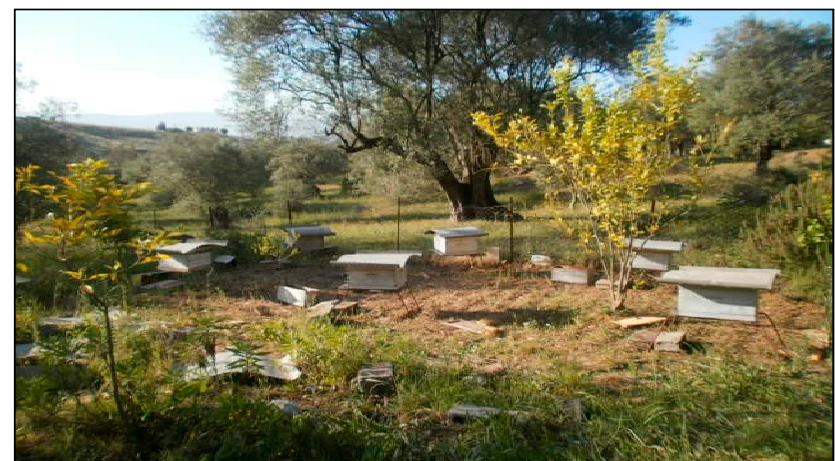
Figure 7. Location of the experimental apiary.